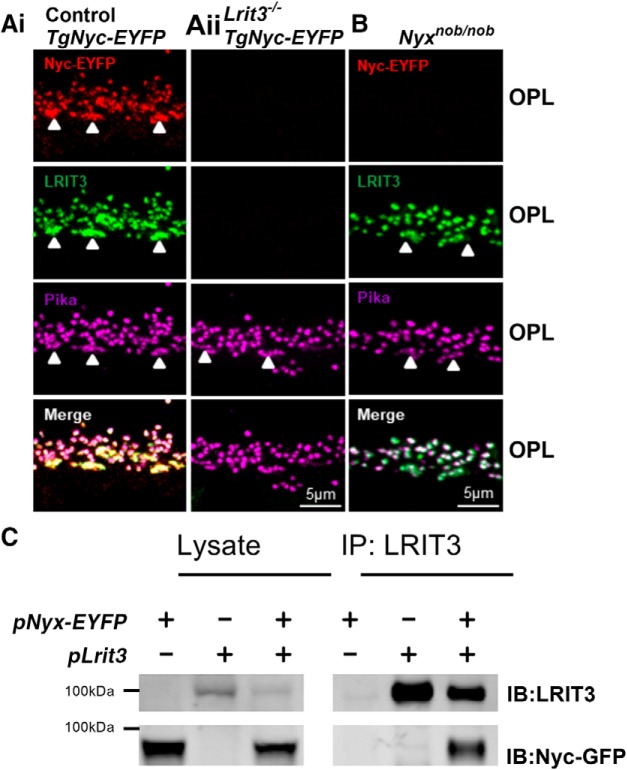

LRIT3 interacts with and is required for nyctalopin expression. A, Confocal fluorescence image of EYFP-nyctalopin (red), LRIT3 (green) and pikachurin (magenta) staining in (Ai) control and (Aii) Lrit3-/-/TgNyc-EYFP retinas. Nyctalopin-EYFP is not expressed in the Lrit3-/-/TgNyc-EYFP retina. Characteristics of the Lrit3-/- mouse are shown in Extended Data Figures 1-1, 1-2. B, In Nyxnob retinas that lack nyctalopin, LRIT3 is expressed and localized to the dendrites of the rod and cone DBCs (marked by arrowheads). Examples show representative images of data from at least three mice. C, LRIT3 and nyctalopin interact in HEK293 cells. HEK293 cells were transfected with expression plasmids pLrit3, pNyx-EYFP or both, and immunoblotted with antibodies against LRIT3 and EYFP. Lanes for the lysates show that the expected proteins were expressed. The remaining lysate was immunoprecipitated (IP) with antibodies against LRIT3 and the precipitates analyzed by western blotting. An asterisk indicates a non-specific band. Blots are representative of at least three experiments.